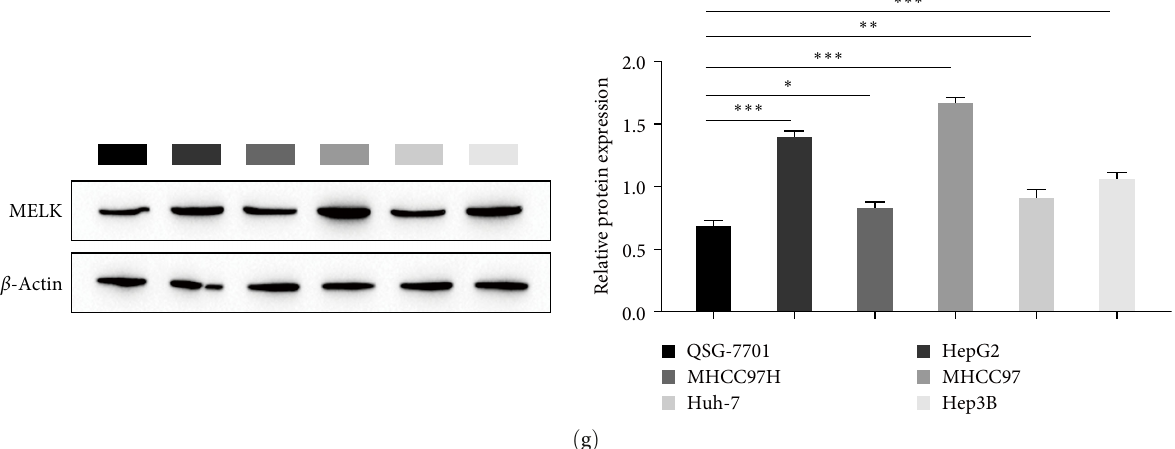
F IGURE 1: High levels of miR-21-5p and MELK in hepatocellular carcinoma: (a) differential heatmap of miRNA expression in liver cancer; (b) volcano plot of miRNA expression in liver cancer; (c) RT-qPCR was used to detect miR-21-5p expression in pathological samples; (d) Western blot was used to detect MELK expression in pathological samples; (e) FISH for the level of miR-21-5p in liver cancer cells; (f) RT- qPCR for the level of miR-21-5p (normal liver cells QSG-7701, hepatoma cells HepG2, MHCC97H, MHCC97L, Huh-7, Hep3B); (g) Western blot for the level of MELK (normal liver cells QSG-7701, liver cancer cells HepG2, MHCC97H, MHCC97L, Huh-7, Hep3B). ∗ P < 0 : 05, ∗∗ P < 0 : 01, ∗∗∗ P < 0 :